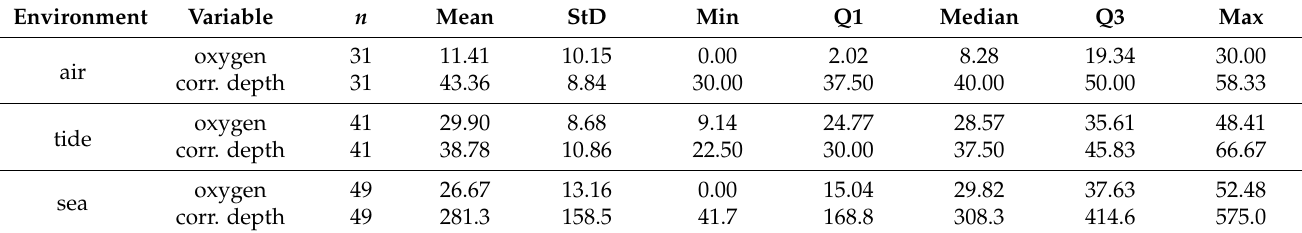
Table 2. The descriptive statistics of input data related to the NiTi1